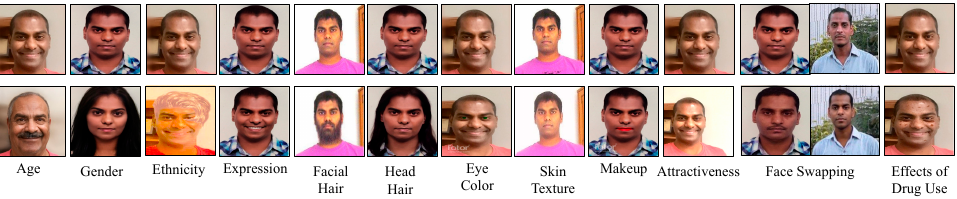
Figure 1. Examples of different face manipulations: original samples (first row) and manipulated samples (second row).